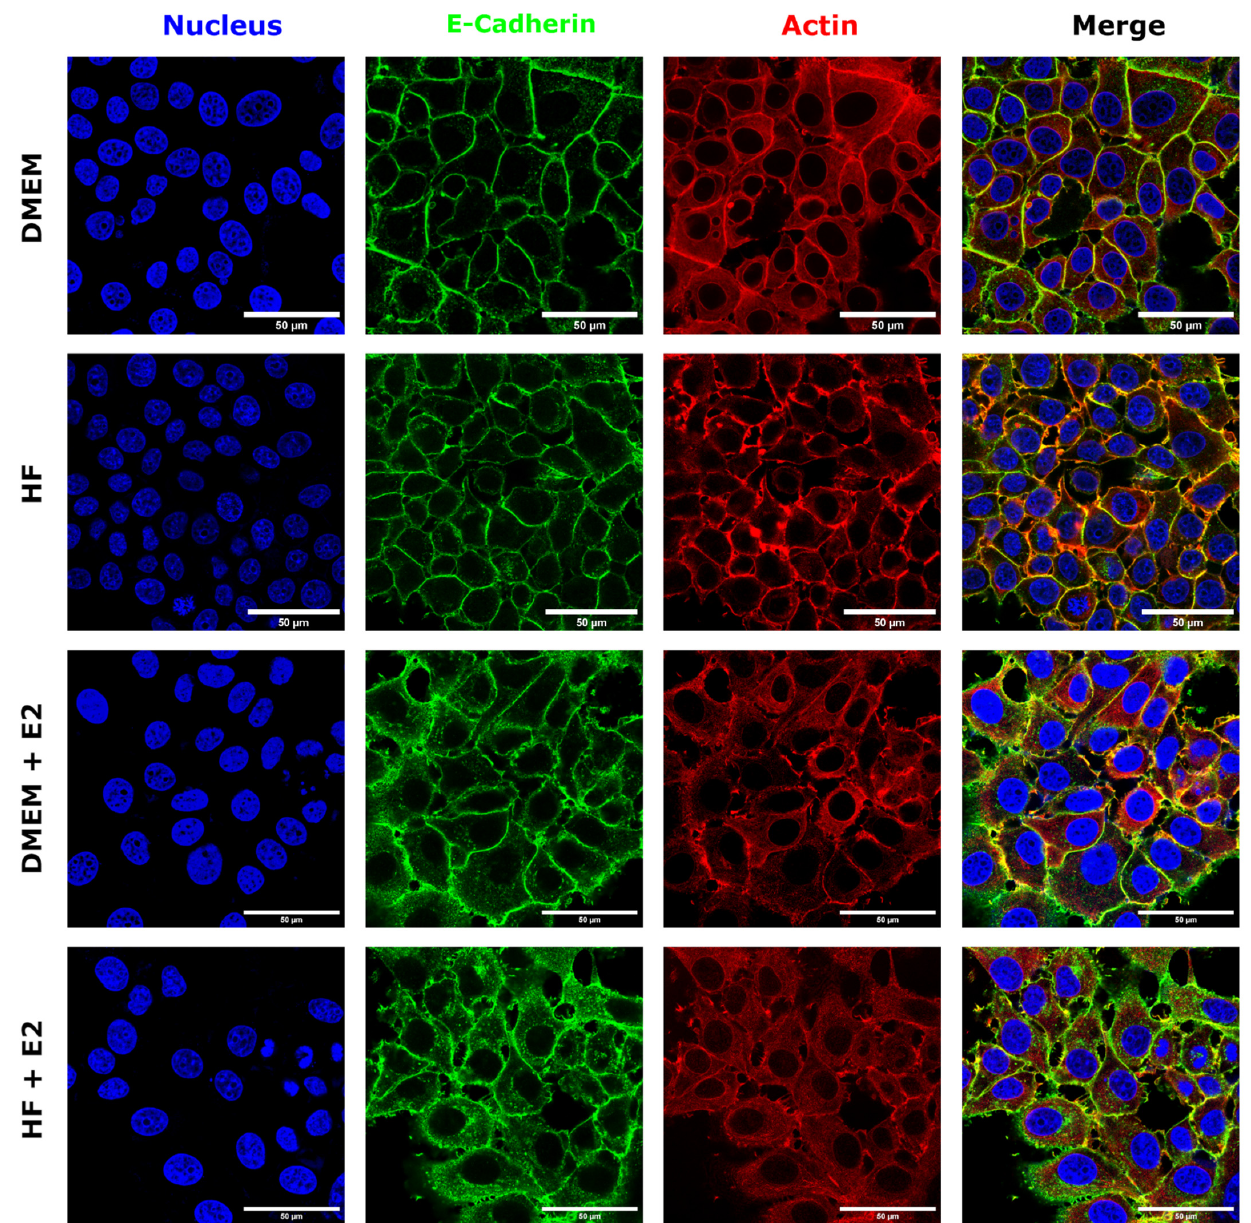
Figure 6. Confocal fluorescence microscopy images of MCF-7 cells grown either in DMEM, HF, DMEM supplemented with 100 nM estrogen or hormone-free medium enhanced with 100 nM estrogen. Nuclei are shown in blue, E-cadherin in green, actin in red. The scale bar corresponds to 50 µm.